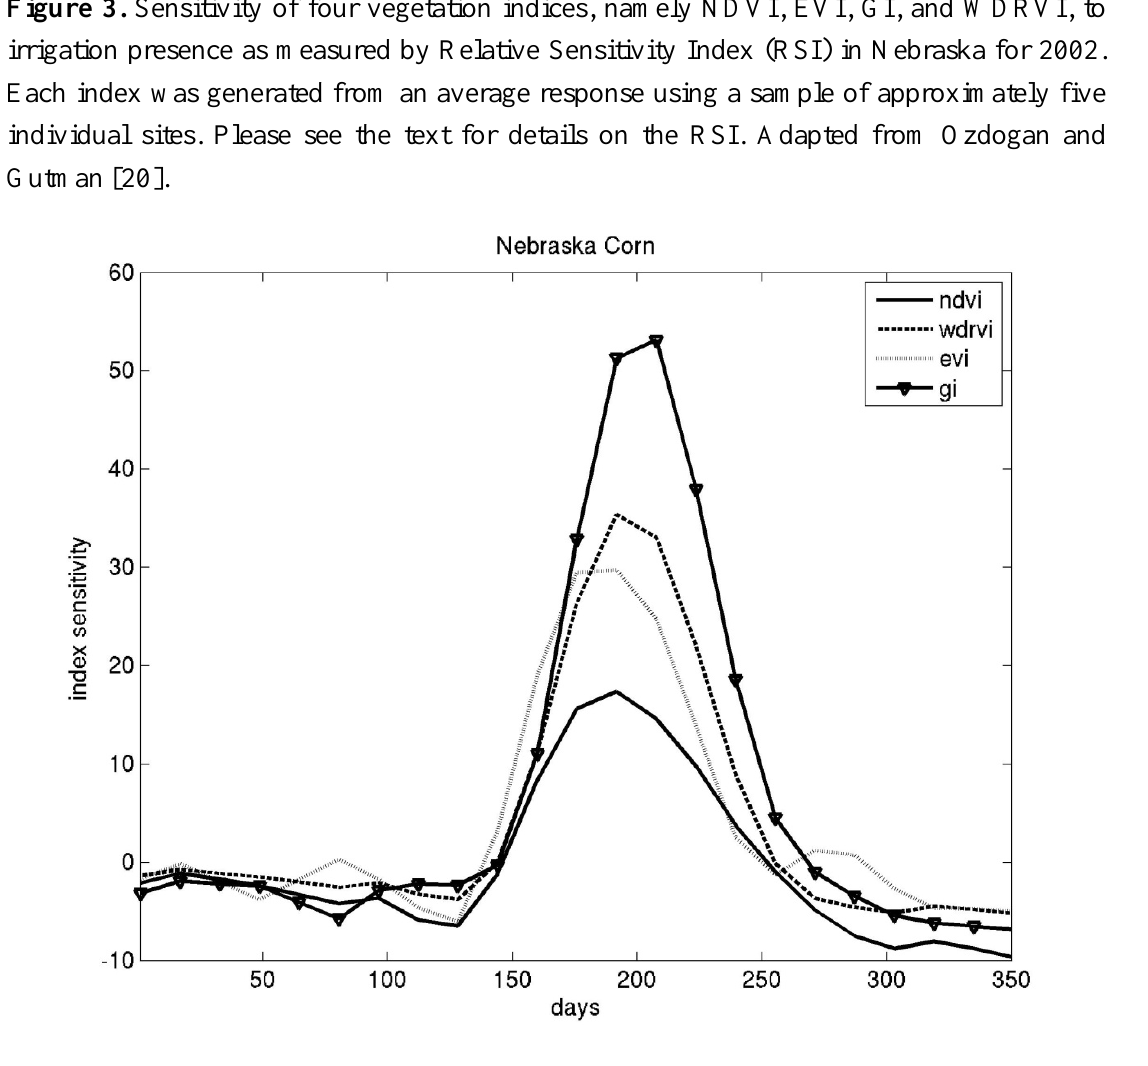
Figure 3. Sensitivity of four vegetation indices, namely NDVI, EVI, GI, and WDRVI, to irrigation presence as measured by Relative Sensitivity Index (RSI) in Nebraska for